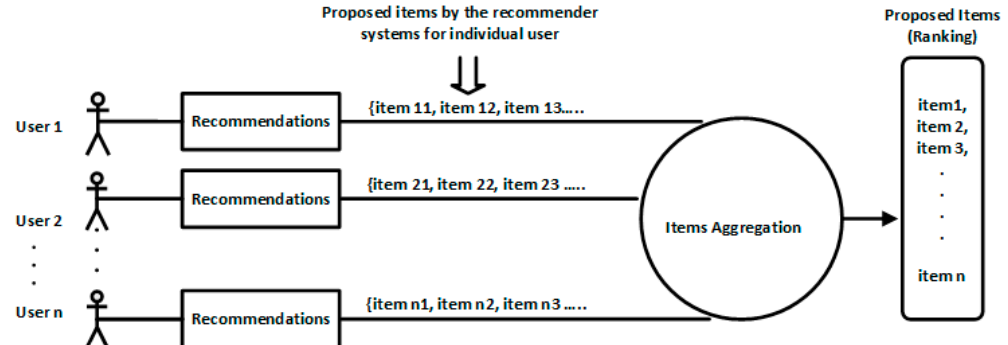
Figure 2. Aggregated prediction techniques in which items are aggregated for group recommendations.